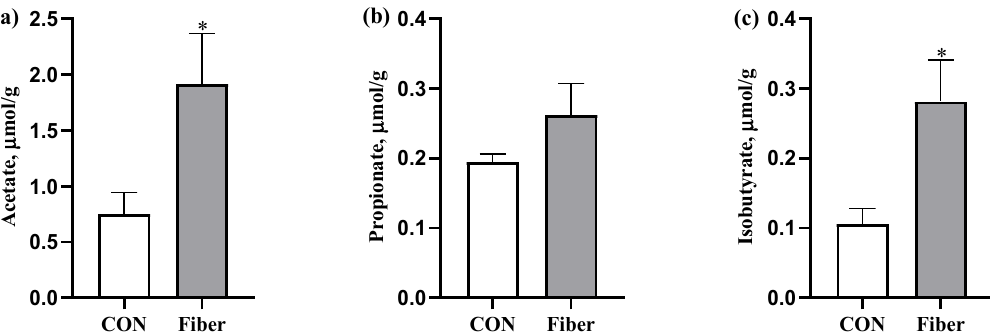
Figure 3. The effects of maternal fiber intake on short-chain fatty acids (SCFAs) levels in colonic digesta of newborn piglets. ( a ), Acetate; ( b ) Propionate; ( c ) Isobutyrate in colonic digesta. Values are presented as mean ± standard error ( n = 8), * means p < 0.05.